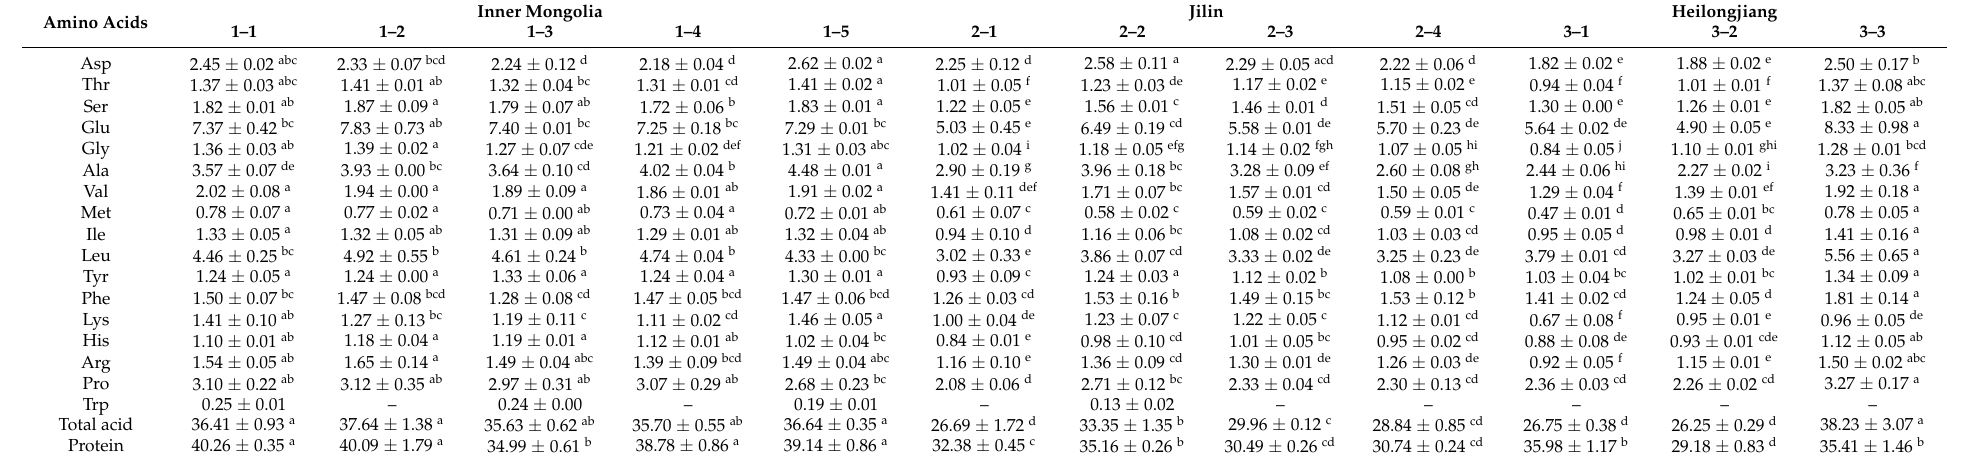
Table 2. Contents of 17 amino acids in fresh sweet–waxy corn from different regions.